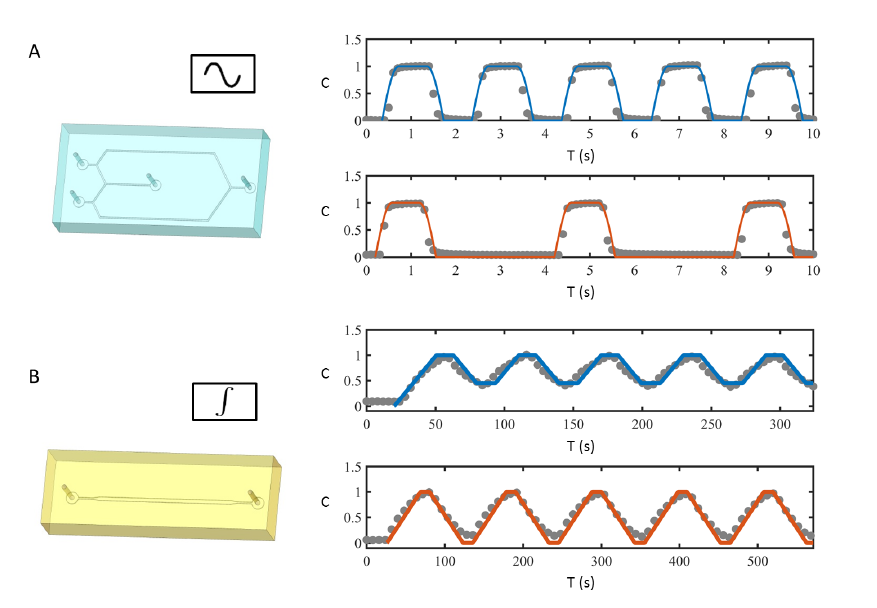
Figure 3. ( A ) ( left ) Oscillator module: ( right ) two signals (symbols) experimentally measured at the outlet of the oscillator and the fitted analytic functions (lines) given by Equation (1); ( B ) ( left ) Integra- tor: ( right ) concentration profiles (symbols) measured at the outlet of an integrator connected to an oscillator and the fitted analytic function given by Equation (3)